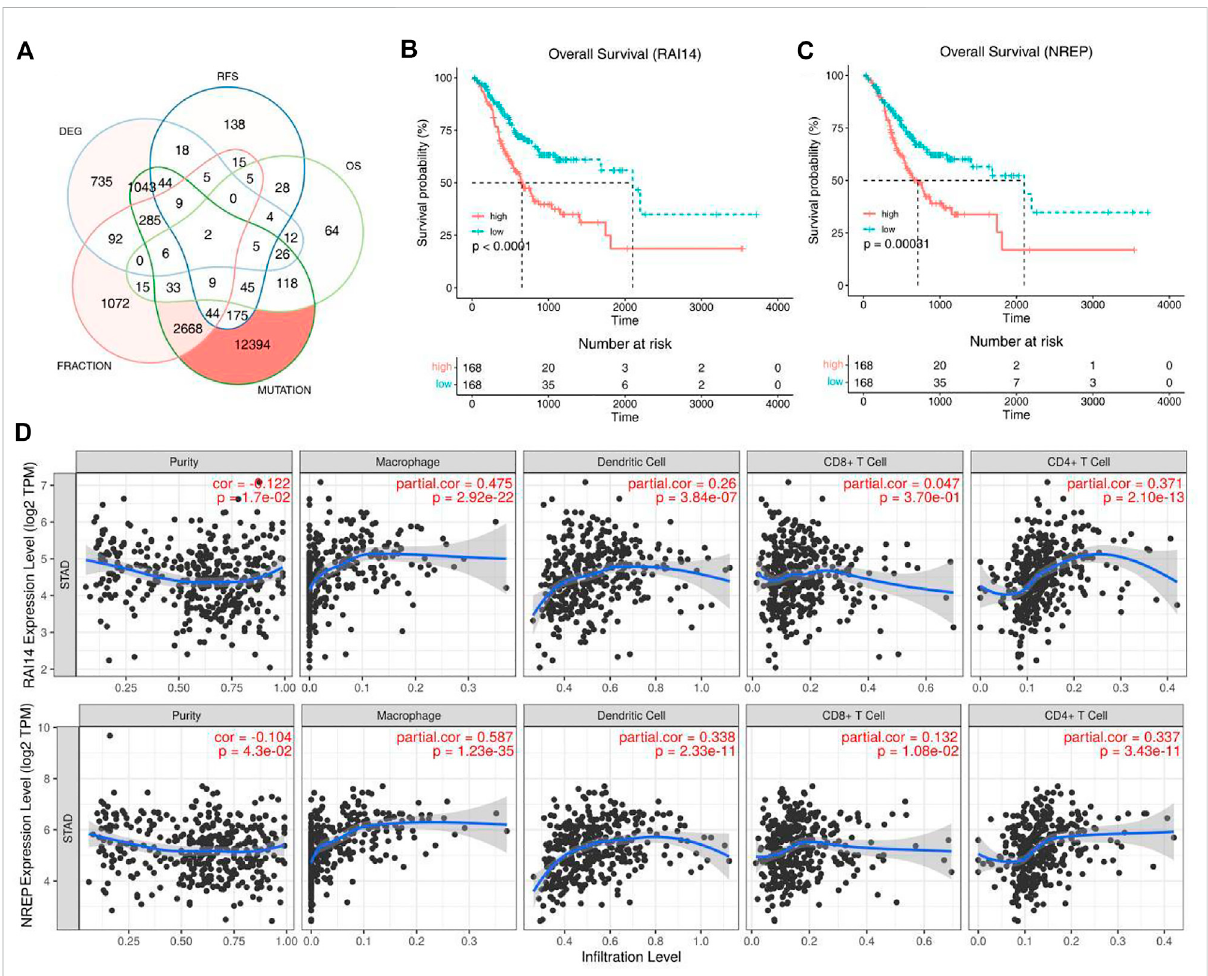
FIGURE 2 Identi fi cation of tumor antigens associated with STAD prognosis. (A) Potential tumor antigens with high expression and mutation in STAD, and signi fi cant association with OS and RFS (total 2 candidates). (B,C) Kaplan-Meier curves showing OS of STAD patients strati fi ed on the basis of (B) RAI14, (C) NREP expression levels. (D) Identi fi cation of tumor antigens associated with APCs. Correlation between the expression levels of RAI14, NREP and in fi ltration of macrophages, dendritic cells, CD8+T cells and CD4+T cells in STAD